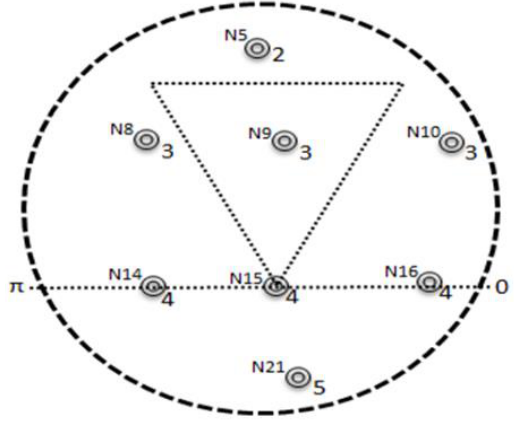
Figure 1. Description of angle adjustment discussed in L2-ABF